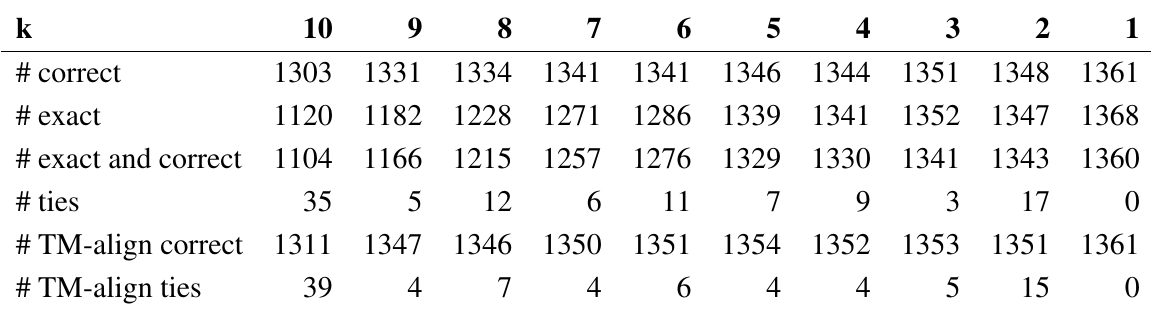
Table 3. Classification results showing the number of queries out of the overall 1369 queries that have been assigned to a superfamily, the number of correct assignments, the number of assignments computed exactly, thereof the number of correct classifications and the number of ties that do not allow a superfamily assignment based on majority vote. The last two lines display the number of correct assignments and ties for k -NN classification using TM-align.